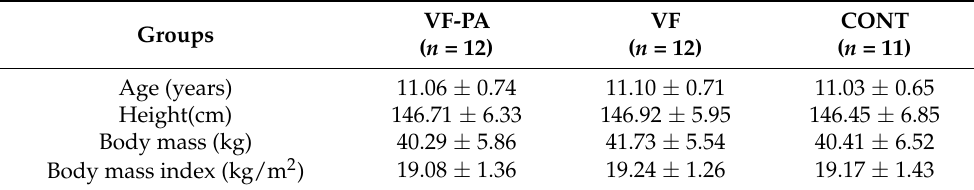
Table 1. Descriptive characteristics (mean ± standard deviation) of the participants.